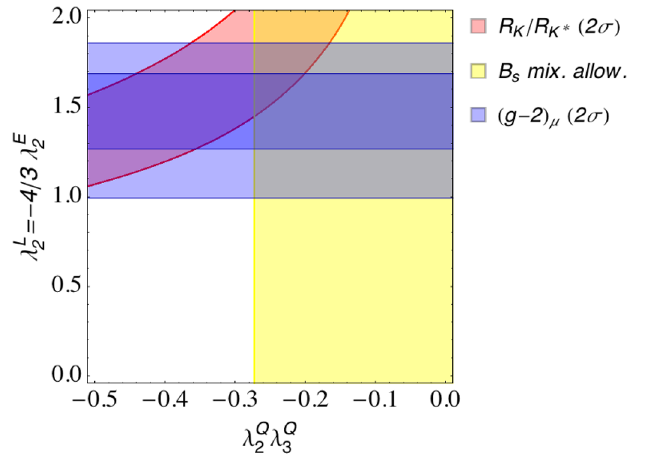
Figure 7 . Regions favoured by the muon g (cid:0) 2 at 2 (cid:27) (blue), b ! s‘‘ (red), and allowed by B s - B s (cid:16) (cid:17) (yellow) on the (cid:21) Q (cid:21) Q ; (cid:21) L = (cid:0) 4 = 3 (cid:21) E plane. The other parameters were set as in (cid:12)gure 3. 2 2 2 3 doublet mixing. The relevant diagram is depicted in (cid:12)gure 6. The leading